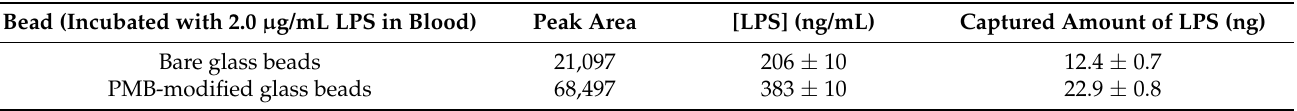
Table 2. Capture of LPS by bare and PMB-modified glass beads *.